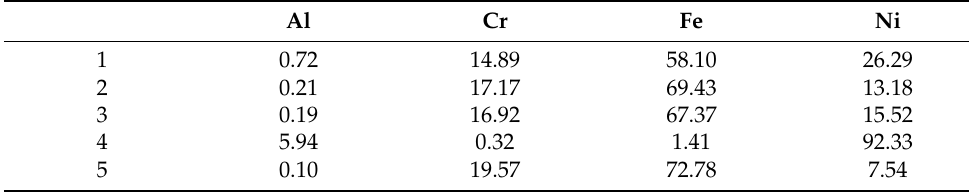
Table 7. Compositions (wt. %) of points at NiAl/304 interface.